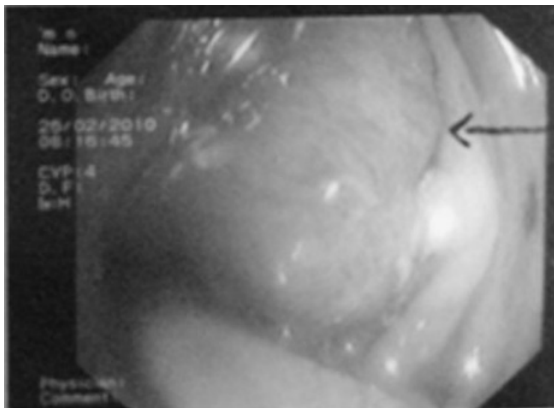
Figure 1. Colonoscopic image showing the metastasis in ascending